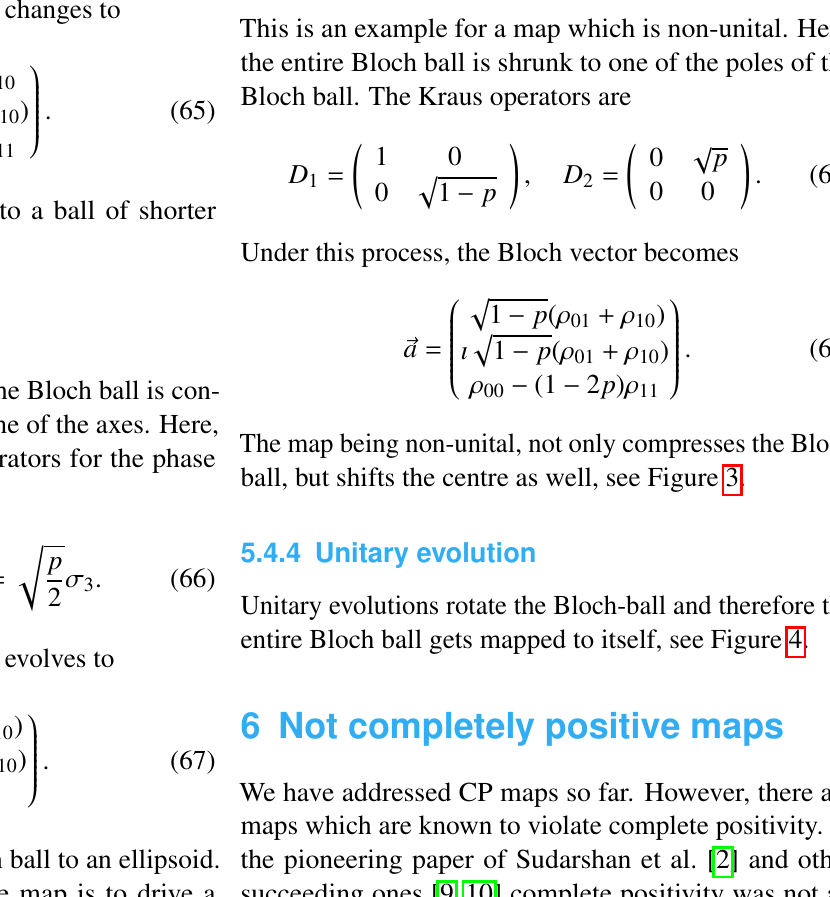
Figure 3: Action of an amplitude damping channel on the Bloch ball. The Bloch ball (outer ball of unit radius) is shown in white. The image is plotted in red.